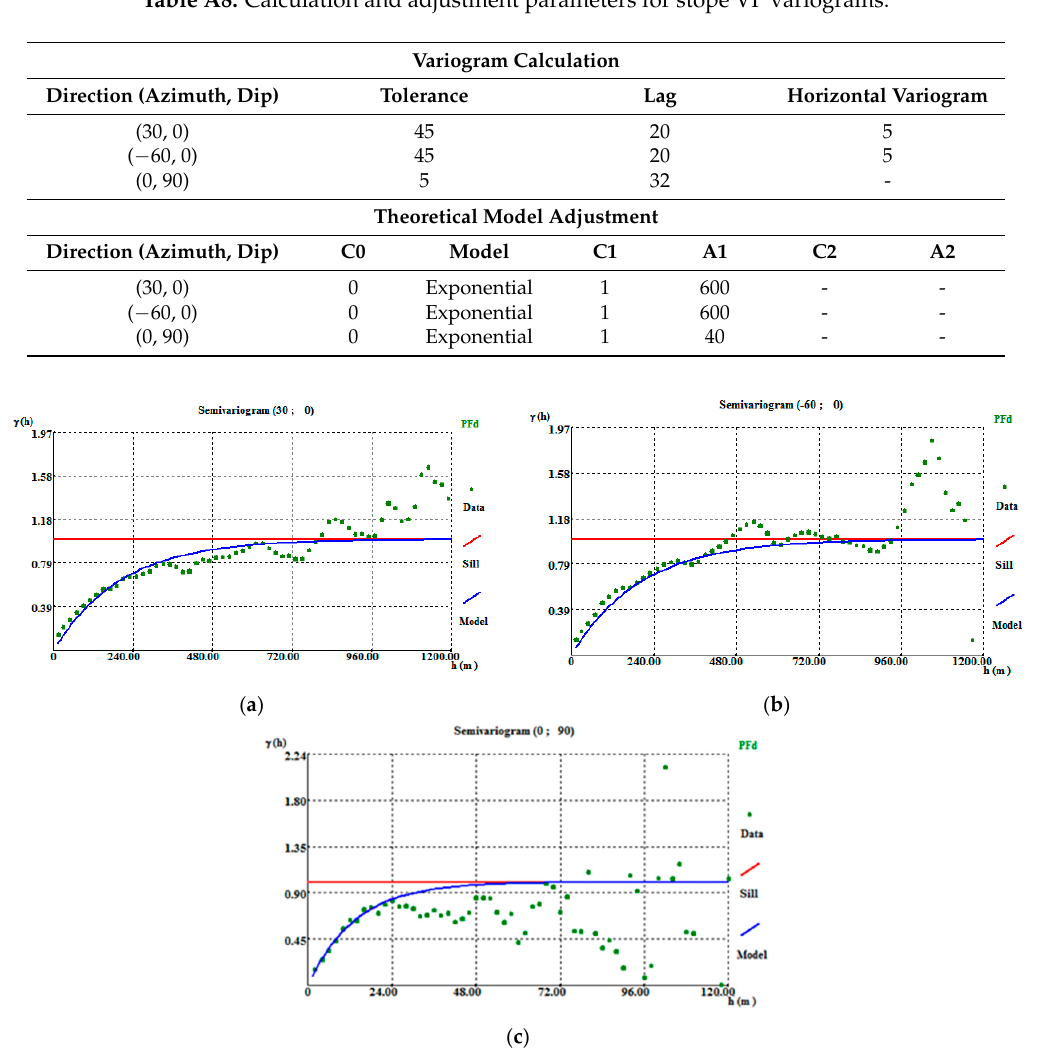
Figure A8. Stope vein proportion directional variograms: ( a ) horizontal (30, 0) variogram; ( b ) horizontal ( − 60, 0) variogram; and ( c ) vertical variogram. The stope data were declustered on a 10 m × 10 m × 2 m grid.